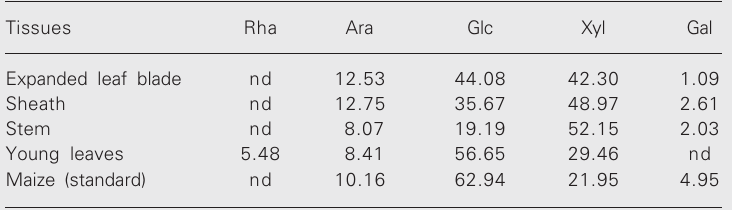
Table 2. Monosaccharide composition of 4 M KOH fractions of expanded leaf blade, sheath, stem, and young leaves of Rhynchelytrum repens and maize (standard). Tissues